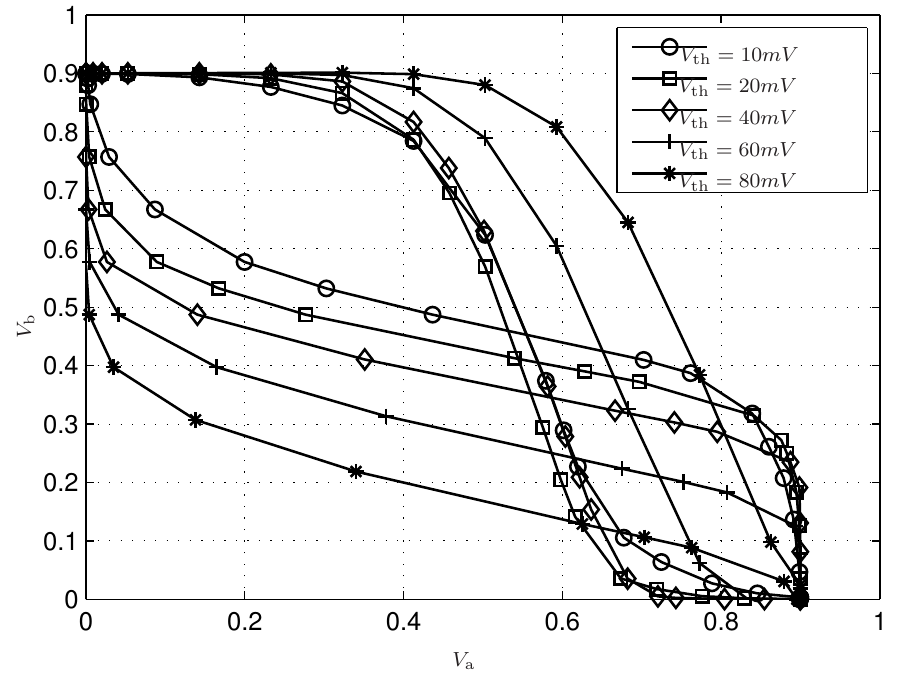
Figure 3. VTC curves of the 22-nm predictive CMOS device model [20] for five different V th